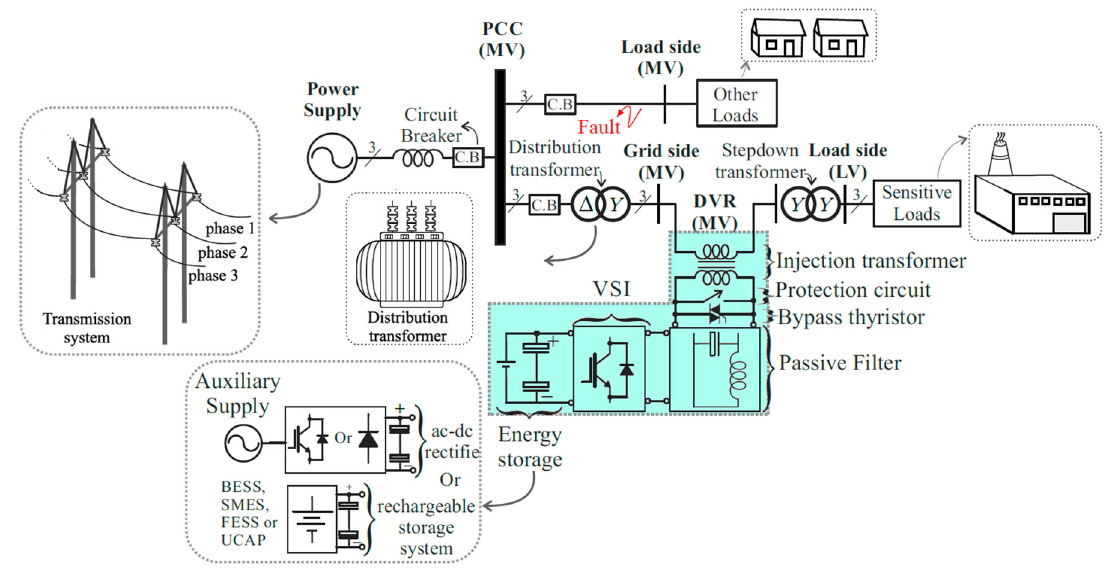
Figure 1. Schematic diagram of the Dynamic Voltage Restorer (DVR) system in the medium voltage distribution network.